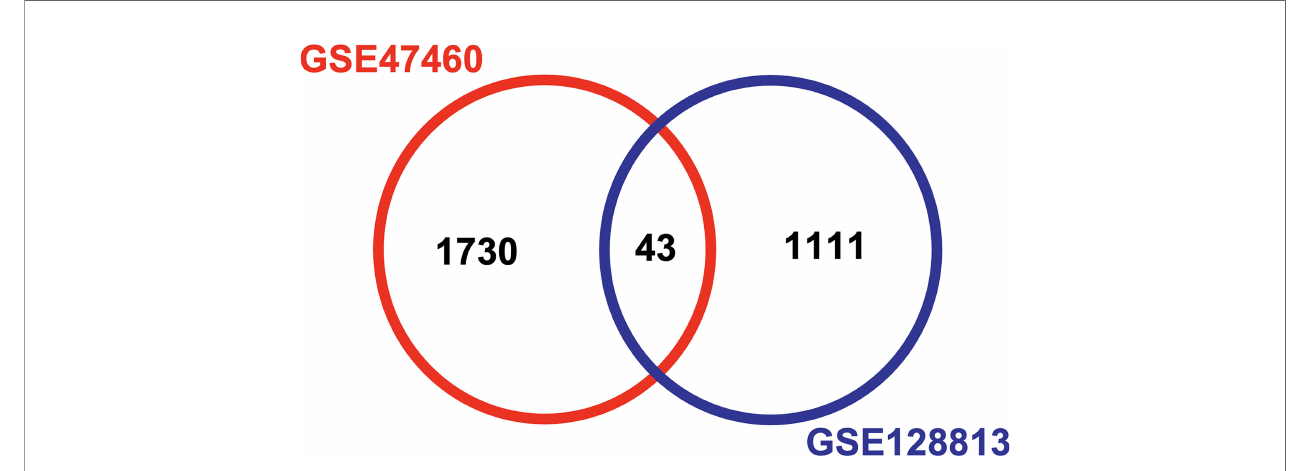
FIGURE 2 | Analysis of differentially expressed genes (DEGs) from GSE128813 and GSE47460 by Venn diagram. The DEGs between fi broblast-like synoviocytes and lung tissue in ILD were identi fi ed by two datasets of transcription pro fi les using Bioinformatics & Evolutionary Genomics (http://bioinformatics.psb.ugent.be/ webtools/Venn/). Difference analysis was de fi ned with p < 0.05 and log2 fold change >1 as the cutoff criterion for screening DEGs. A total of expressed 43 DEGs were identi fi ed in two datasets. GSE, gene expression series; ILD, interstitial lung